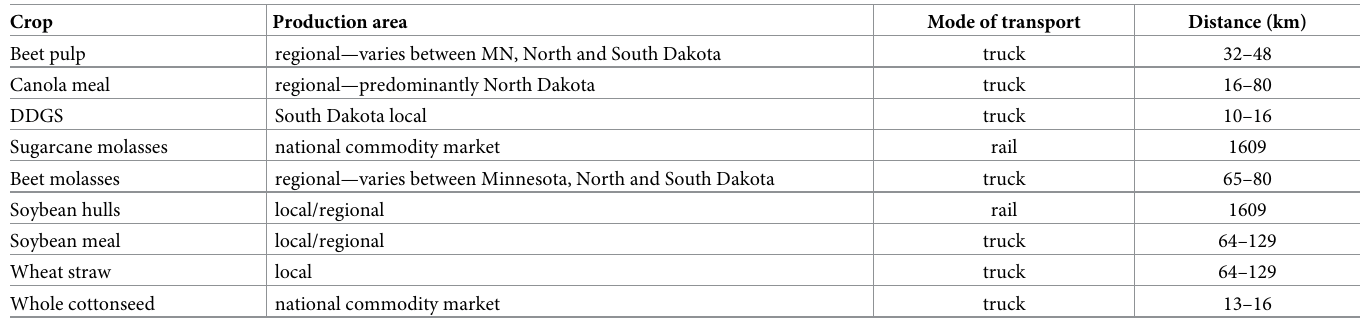
Table 3. Coproduct or byproduct production region, mode of transportation and distance traveled.